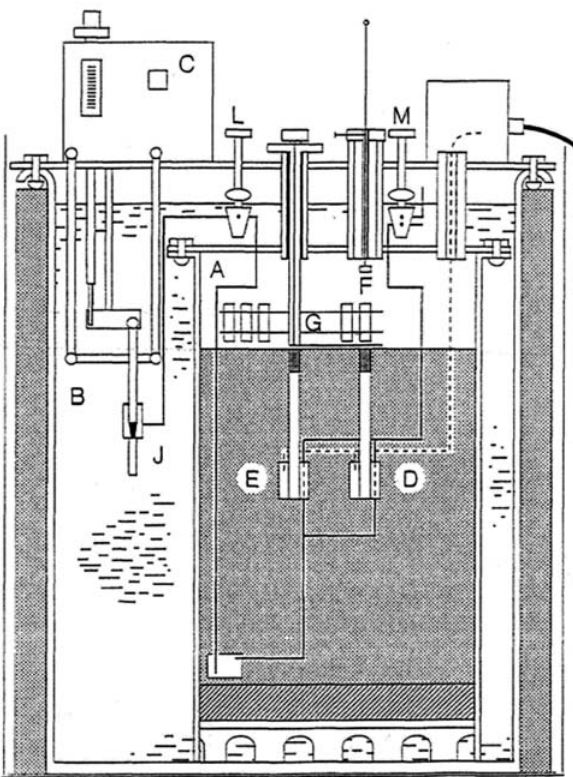
Figure 2. A sketch of the micro-calorimeter used. The calorimeter chamber, A, is submerged in a water bath, B, which is temperature regulated by the thermostat, C. Most of the chamber is filled with polystyrene foam which contains the measuring block, D, and an identical reference block, E. The sample is placed using a magne- tic drive, F, on a turntable, G, by which the sample (the cell) is transferred to the measuring block, D, though the magnetic drive after temperature equilibrium is obtained. The two measuring blocks, D and E, are temperature equalized by a water circulatory system consisting of a water injecting pump J and the valves L and M. The valves may be switched so that the tubing system will be filled by air for heat insulation when the apparatus is in measuring